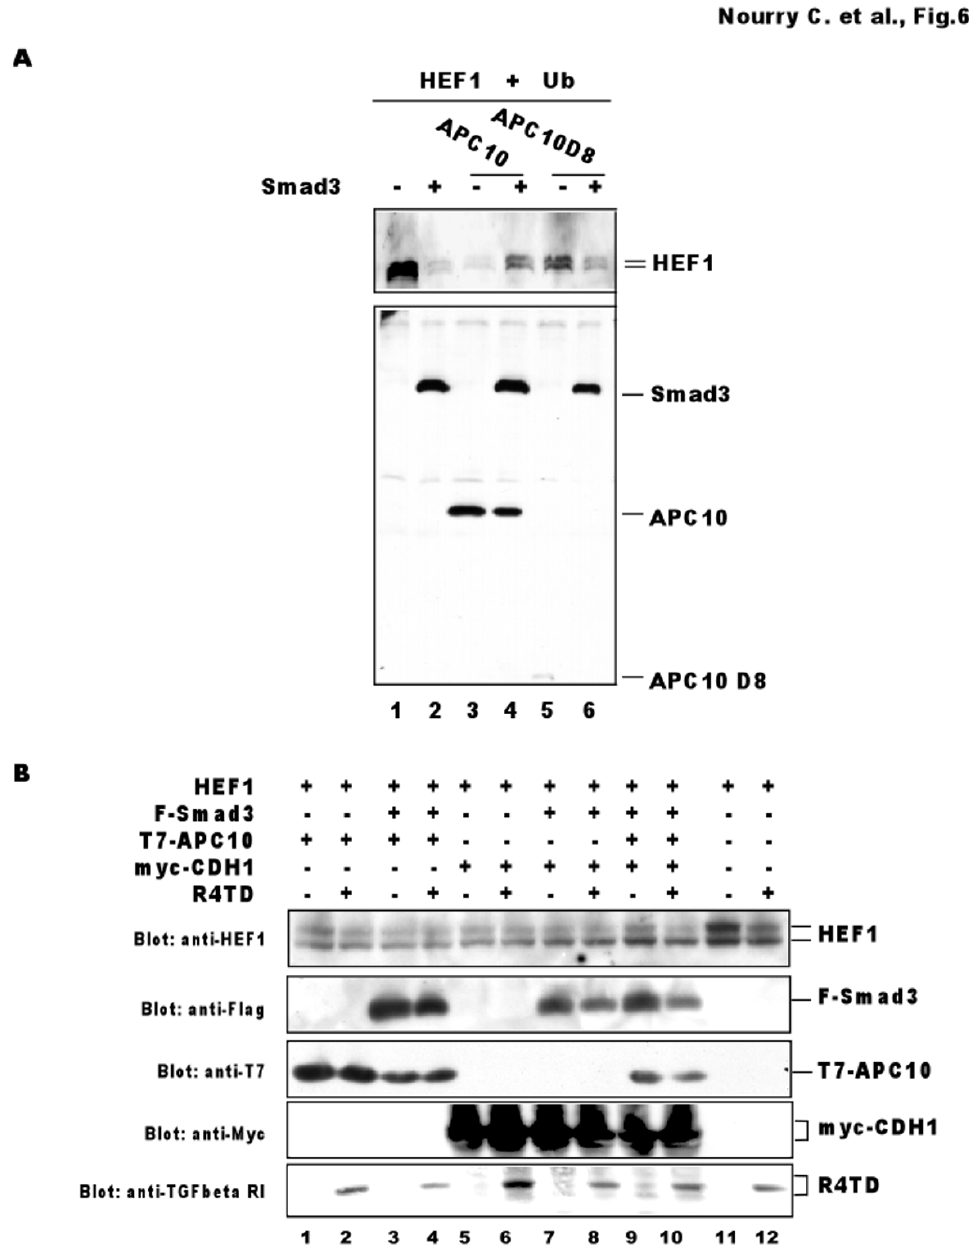
Figure 6 Both APC10 and CDH1 can alter the steady state protein levels of HEF1 (A) Overexpressed APC10 caused the reduction of the steady-state protein levels of HEF1 and such an activity is compromised in a deletion mutant of APC10 (APC10 D8) that is defective in binding to Smad3. HEF1 was co-transfected with ubiquitin, Flag-Smad3, T7-APC10 or T7- APC10 deletion mutant APC10 D8. The expression level of HEF1 was detected by Western blot using anti-p130Cas antibody, as shown in the top panel; the expression of Smad3, APC10 and APC10D8 were detected by Western blot using anti-Flag and anti-T7, as shown in the bottom panel. (B) CDH1 enhances Smad3-regulated HEF1 degradation. HEF1 was co-expressed in dif- ferent combinations with myc-CDH1, T7-APC10, Flag-Smad3 and R4T204D (R4TD), a constitutively active type I receptor in 293 cells. The steady state levels of HEF1 were detected by anti-HEF1 antibody (top panel) and the expression levels of Smad3 and APC10 were detected with anti-Flag and anti-T7 antibodies, respectively (second and third panels), while the expression levels of myc-CDH1 were detected by anti-Myc (fourth panel). To detect R4-TD, cell lysates were blotted with anti-TGF- β RI antibody (bottom